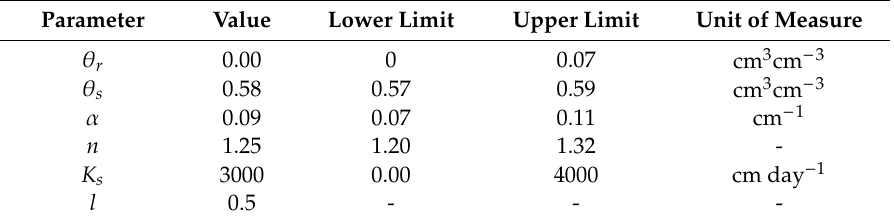
Table 3. Estimated soil hydraulic parameters . θ r, residual water content; θs , saturated water content; α , inverse of the air-entry pressure head; n , pore-size distribution index; and l , tortuosity.